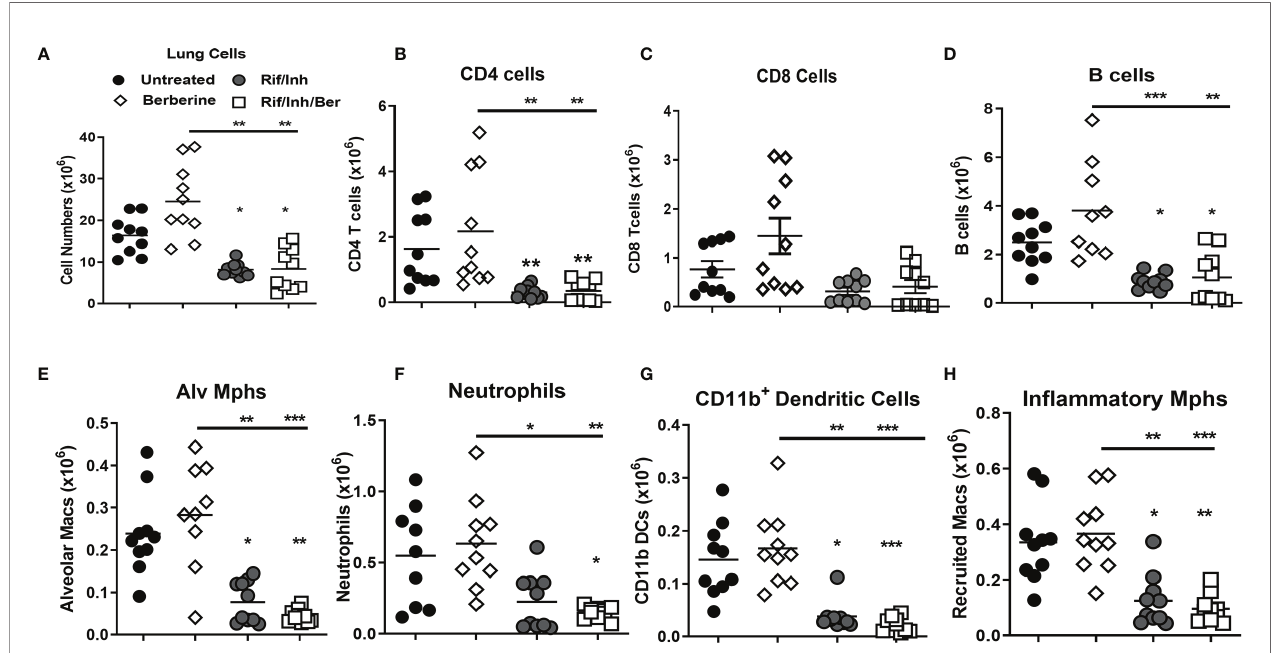
FIGURE 4 | Effect of berberine on lung immune cells populations as an adjunctive therapy during Mtb infection in C57BL/6 mice. Single-cell suspension of lungs was analyzed for immune cell populations by fl ow cytometry at 5 weeks post-infection; (A) Total lung cells, (B) CD4 T cells (CD19 - CD3 + CD4 + ), (C) CD8 T cells (CD19 - CD3 + CD8 + ), (D) B cells (CD19 + CD3 - ), (E) Alveolar macrophages (Siglec-F + CD11c + ), (F) Neutrophils (Gr1 + Siglec-F - Cd11c - ), (G) Dendritic cells (CD11c + CD11b + MHCII + ) and (H) in fl ammatory macrophages (CD11b + CD11c - MHCII + ). Data is shown from pooled two experiments (n = 10 per group) and the line denotes mean value analysed by Kruskal-Wallis test with Dunn ’ s multiple comparisons correction de fi ning differences in all groups as signi fi cant *P ≤ 0.05; **P ≤ 0.01; ***P ≤ 0.001. Asterisks without the line below show the signi fi cance compared to the untreated